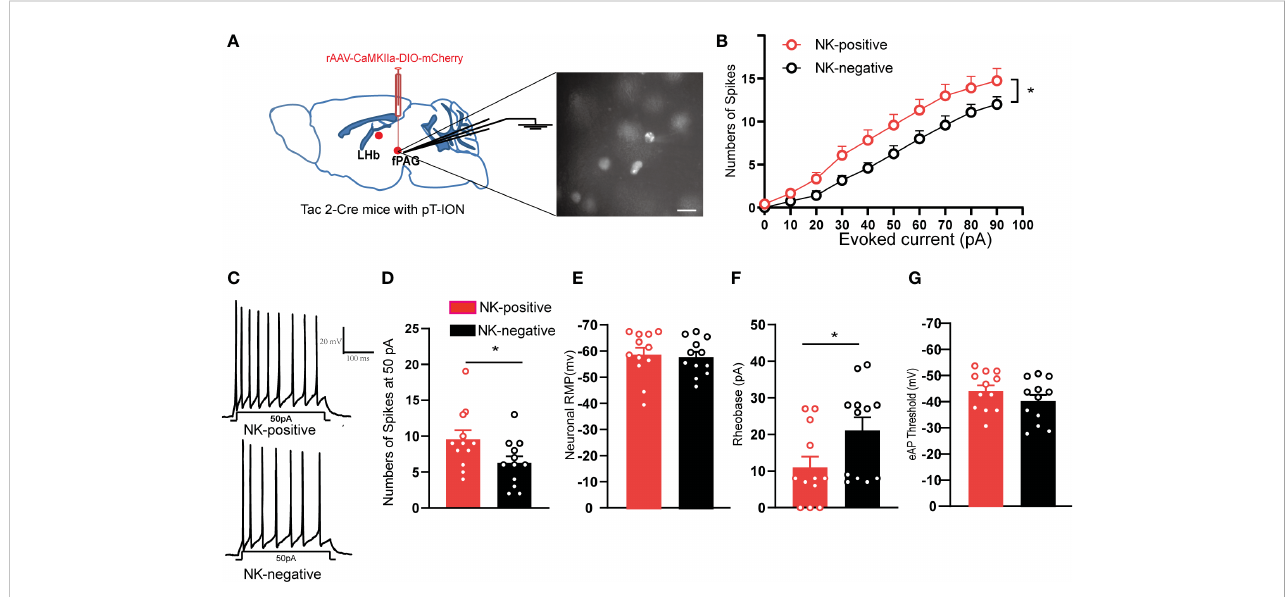
FIGURE 9 The fPAG NKB-positive neurons were active in pT-ION mice. (A) Schematic of rAAV-CaMKIIa-DIO-mCherry injection and the recording con fi guration in the fPAG (left). Sample image showing NKB-positive neurons labelled with mCherry through virus injection into the fPAG of Tac2-Cre mice (right). Scale bar, 10µm. (B) Firing spikes recorded from the fPAG neurons of NKB-positive and NKB-negative neurons of pT-ION Tac2-cre mice. (C) Sample traces of evoked action potentials at 50 pA current stimulation recorded from NKB-positive and NKB-negative neurons in the fPAG. (D – G) Data of evoked action potential fi ring spikes at 50 pA current stimulation (D) , RMP (E) , rheobase (F) , and evoked action potential threshold (G) recorded from NKB-positive and NKB-negative neurons in the fPAG (*p < 0.05 vs. NKB-negative neurons, n = 12 neurons in NKB-positive and n = 12 neurons in NKB- negative from 5